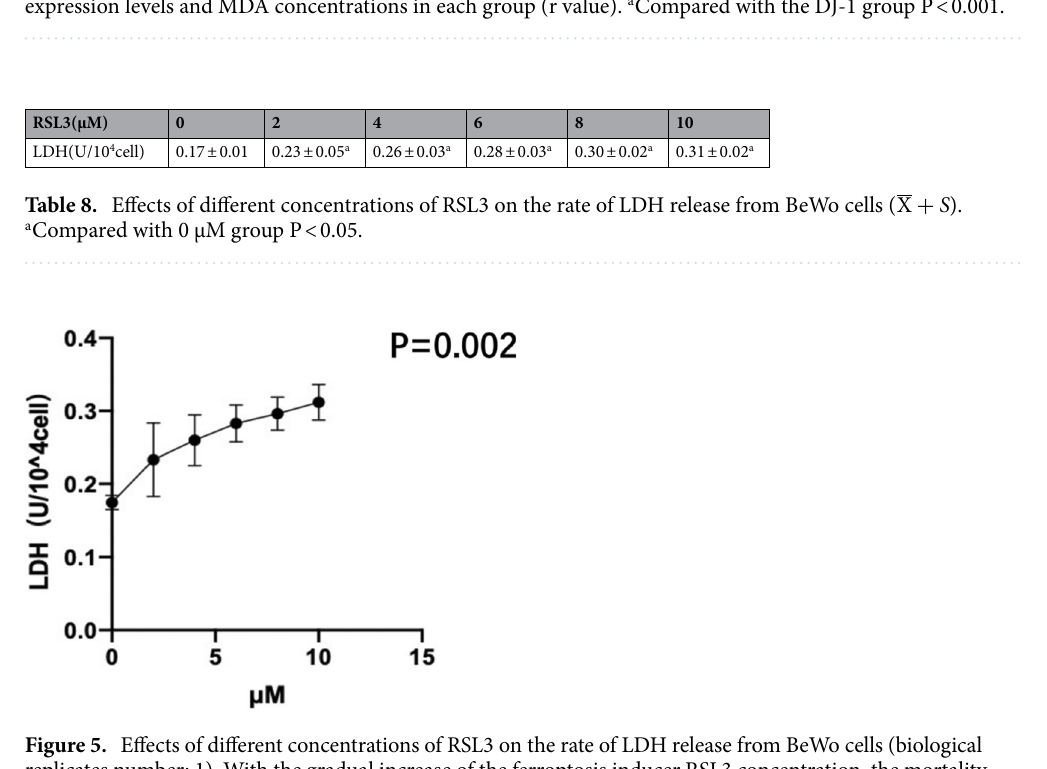
Figure 7 show transfection efficiency data. In the blank group, when compared to the bright-field images, the fluorescent cell ratio of the dark-field images was almost 0 (Fig. 7A,B). Compared with the bright-field images, the fluorescent cell ratio of the dark-field images in the DJ‑1 overexpression group (expressed in DJ‑1 + / +) (Fig. 7C,D), the DJ-1+/+ negative control group (Fig. 7E,F), the DJ‑1 inhibited expression group (expressed in DJ‑1 −/−) (Fig. 7G,H), and the DJ‑1 −/− negative control group (Fig. 7I,J), ranged from 60 to 70% (magnification × 200) (biological replicates number: 2). Expression levels of DJ‑1 and Nrf2/GPX4 signal pathway mRNA in transfected BeWo cells. Ex‑ pression levels of DJ‑1 mRNA in transfected BeWo cells. Figure 8 shows that the expression levels of DJ‑1 mRNA in BeWo cells from the DJ‑1 + / + group were significantly higher than those in the DJ‑1 + / + negative control group [ DJ‑1 + / + vs. DJ‑1 + / + negative control = (2.97 ± 0.95) vs. (0.80 ± 0.07), P < 0.001]. The expression levels of DJ‑1 mRNA in BeWo cells from the DJ‑1 −/− group were significantly lower than those in the DJ‑1 −/− negative control group [ DJ‑1 −/− vs. DJ‑1 −/− negative control = (0.52 ± 0.18) vs. (1.35 ± 0.38), P = 0.042]. The expression levels of DJ‑1 mRNA in BeWo cells from the DJ‑1 + / + group were significantly higher than those in the DJ‑1 −/− group[ DJ‑1 + / + vs. DJ‑1 −/− = (2.97 ± 0.95) vs. (0.52 ± 0.18), P < 0.001]. These results showed that the transfection effect of DJ‑1 lentivirus in BeWo cells was effective (biological replicates number: 2).